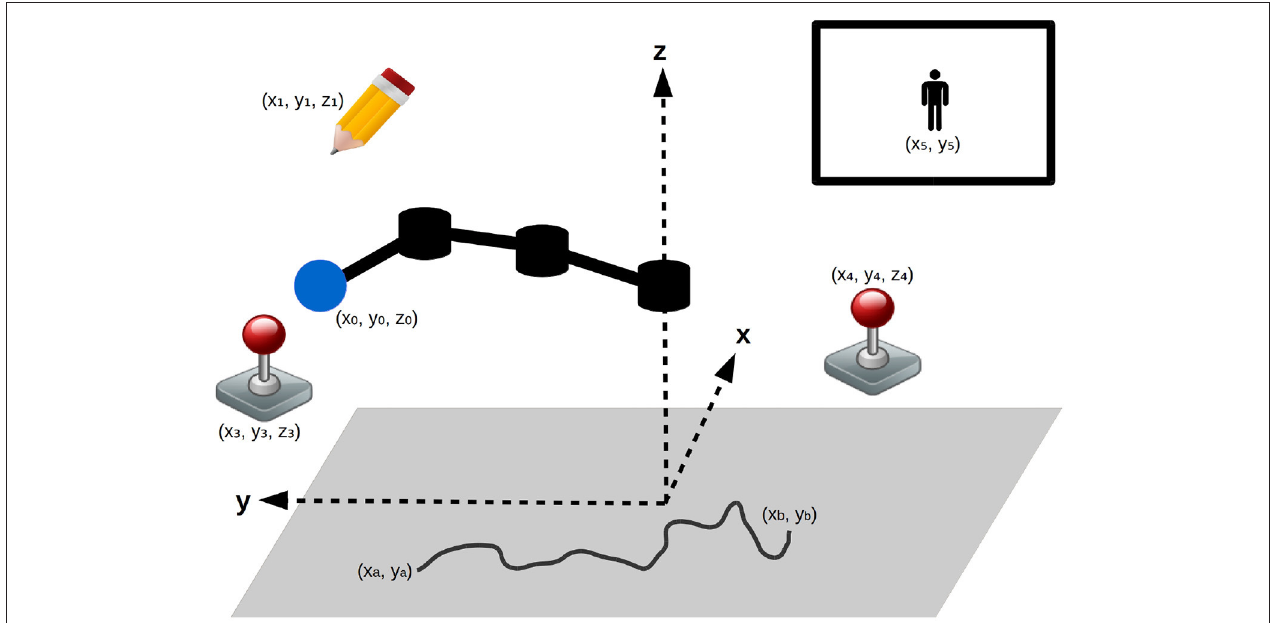
FIGURE 3 | Experimental setup: a robotic arm, can interact with the different objects in its environment (a pen and two joysticks). Both joysticks enable to control a video-game character (represented in top-right corner). A gray floor limits its motions and can be drawn upon using the pen (a possible drawing is represented).